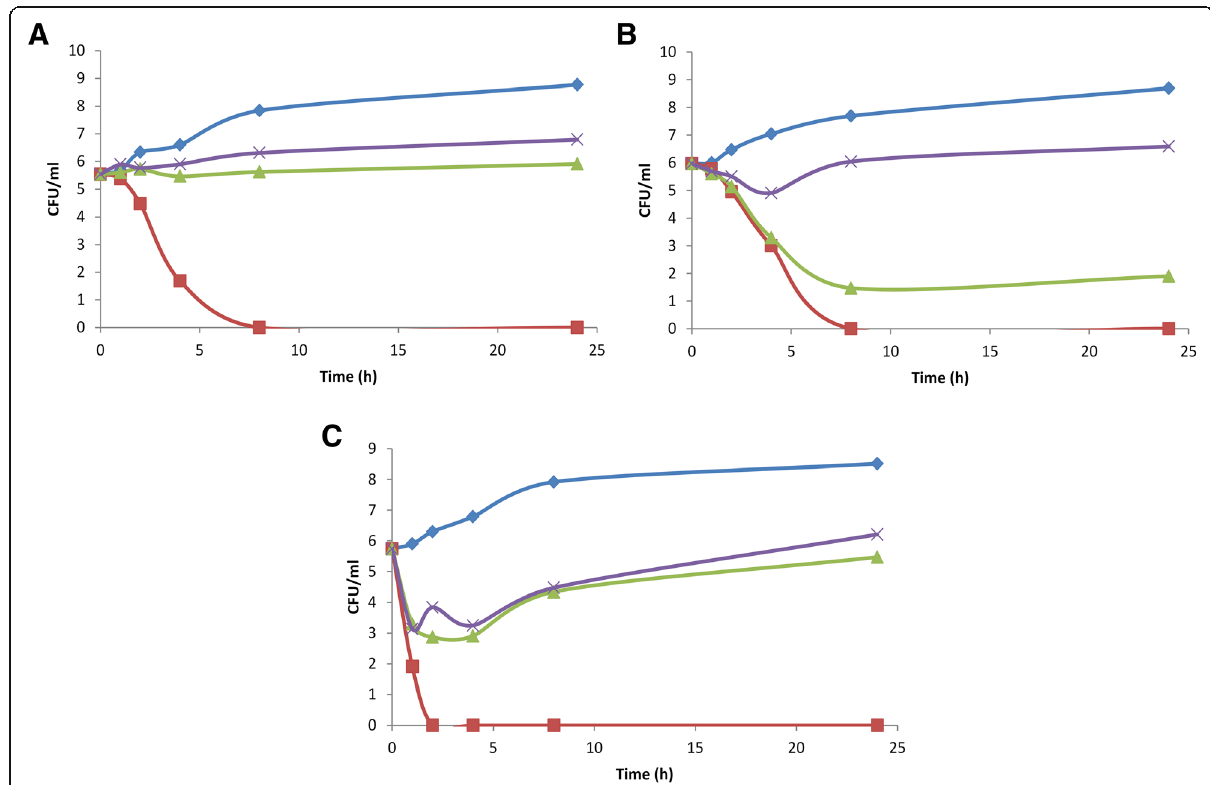
Fig. 1 Killing curves for pistachio hull EO against C. albicans strain 16 ( a ), C. glabrata strain 9 ( b ) and C. parapsilosis strain 26 ( c ). Control, ♦ ; 1/ 4xMIC, ×; 1/2xMIC, ▲ ; 1xMIC, ■ . Mean of three experiments. MIC = minimum inhibitory concentration